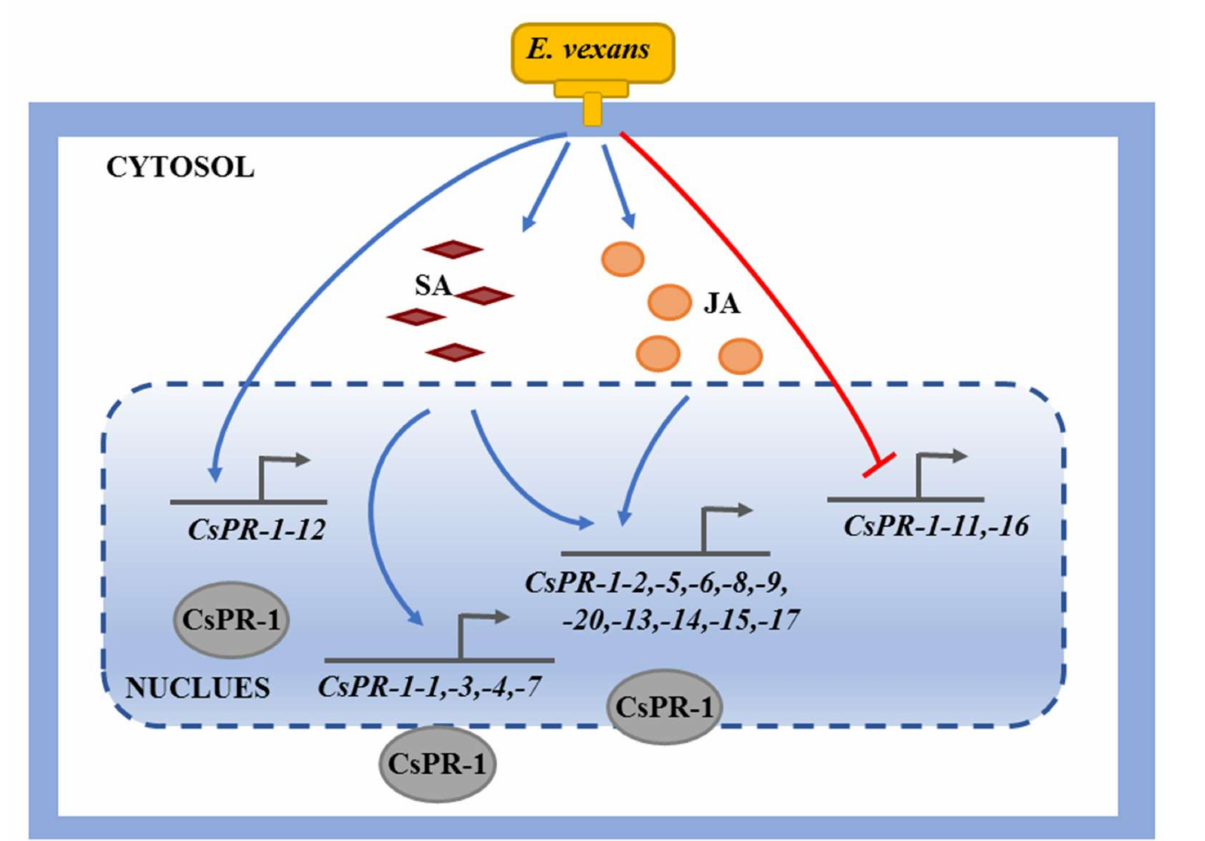
Figure 8. Proposed model of CsPR-1 -modulated blister blight in tea plants. The blue arrow indicates the upregulation of genes; the red arrow indicates the downregulation of